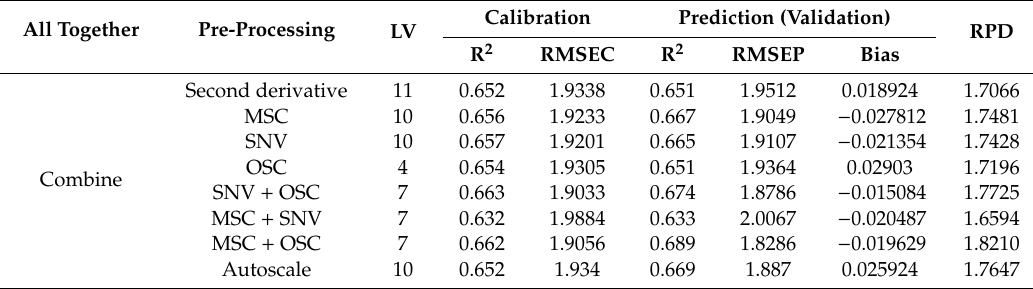
Table 8. PLSR results of combine data with second derivative and their preprocessing at a spectral sampling range of 729–975